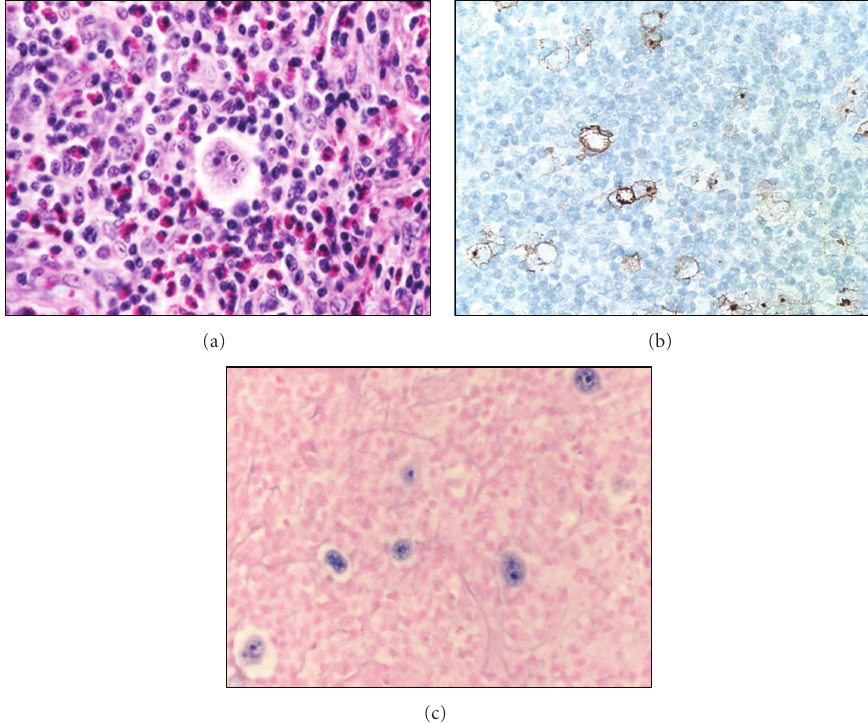
Figure 1: Representative images of mixed cellularity HIV-associated classical Hodgkin’s lymphoma. (a) High-power H and E image shows a prominent Hodgkin Reed Sternberg (HRS) cell surrounded by a mixed population of lymphocytes, eosinophils, granulocytes, and histiocytes. (b) Low-power view of CD30 immunohistochemistry highlights the rare large HRS cells, as does in-situ hybridization for EBER (c), reflecting the Epstein-Barr virus (EBV) infection of HRS